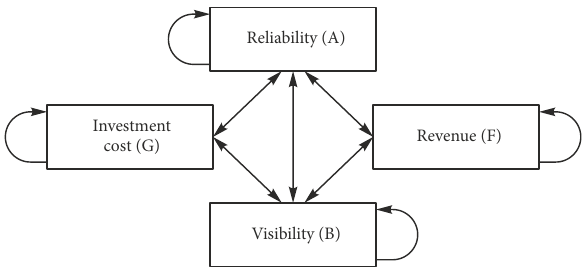
Figure 13. Relationship between dimensions preferred